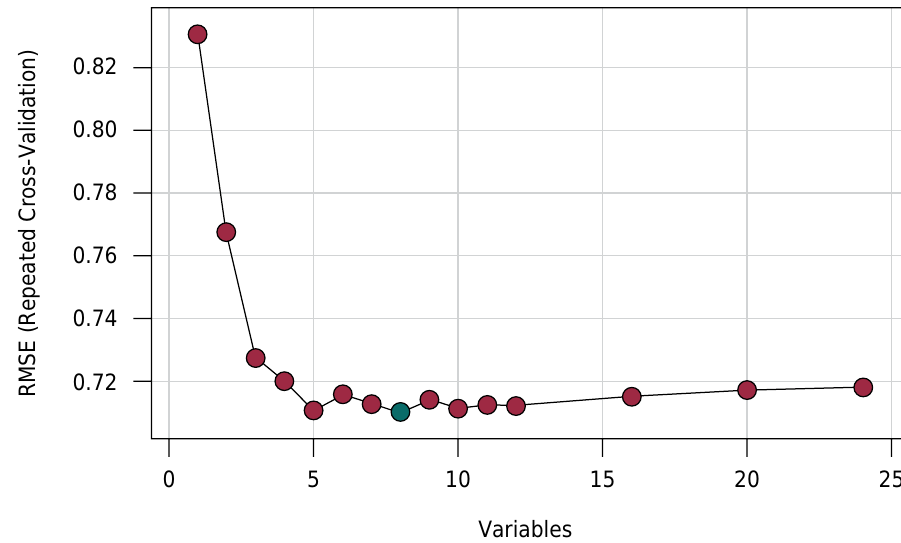
Figure 2. Diagram of the RFE-RF curve for pH 0.00-0.30 m showing the number of covariates (x-axis) and changes in RMSE values (y-axis).